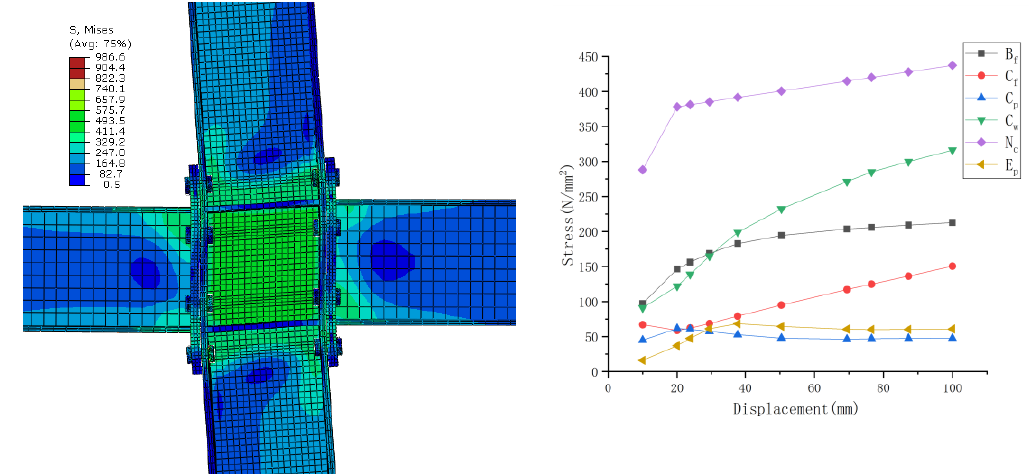
Figure 12. Stress distribution and stress history at specified points of a 12-mm end-plate.